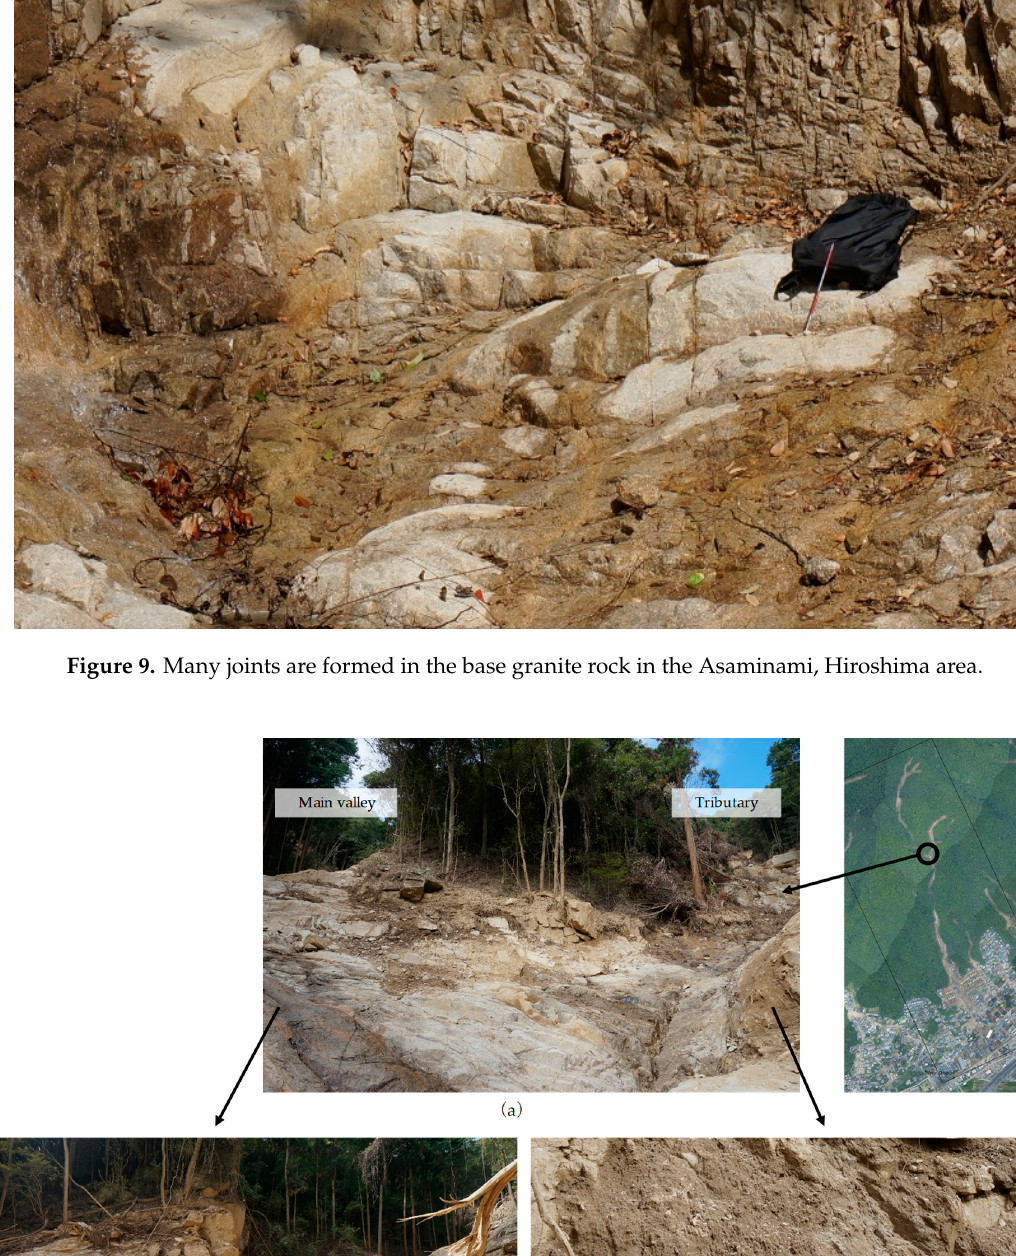
Figure 8. Fragile granite in the valley, Asaminami, Hiroshima.